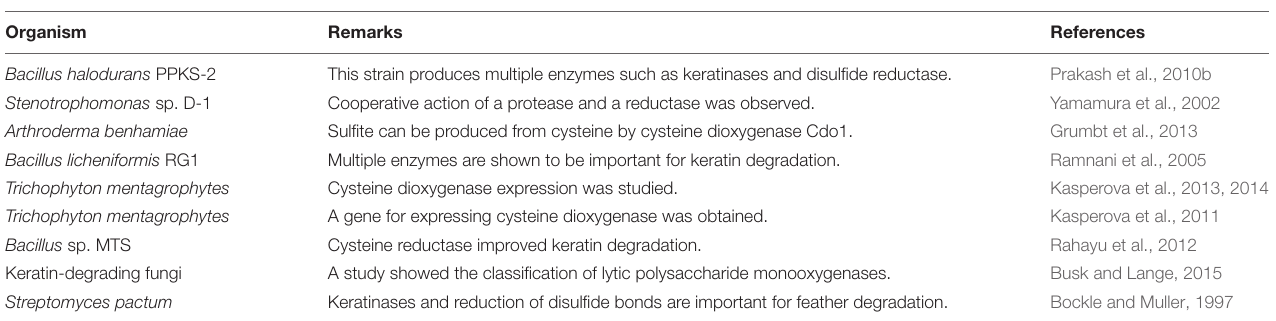
FIGURE 2 | A simplified diagram showing the degradation of keratin by proteases. Two-step disulfide bond breakage and polypeptide degradation are usually included in keratin degradation. Keratins are simplified as helices. The degradation includes the steps such as releasing of keratin and degradation of keratin by multiple enzymes, which has been described in several reviews (Korniłłowicz-Kowalska and Bohacz, 2011; Sharma and Devi, 2018; Vidmar and Vodovnik, 2018; Qiu et al., 2020). TABLE 1 | Some studies on other enzymes important for keratin degradation are